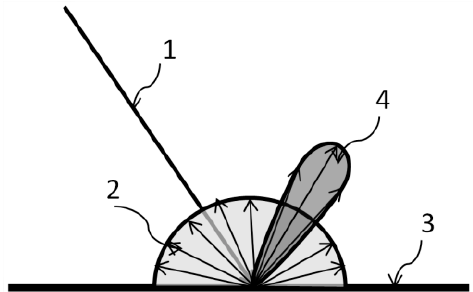
Figure 2. Reflection model of diffuse and specular components.